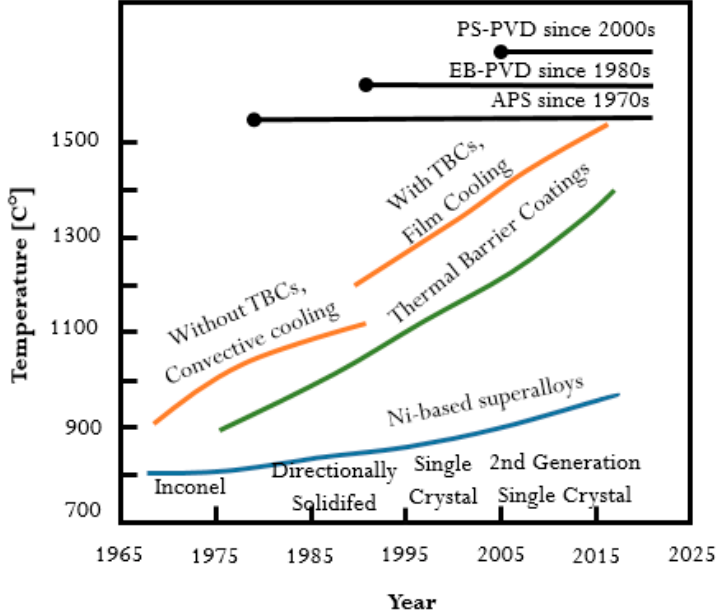
Figure 1. Development of nickel-based superalloys and TBCs over the years in relation to the gas turbine engine operating temperature.